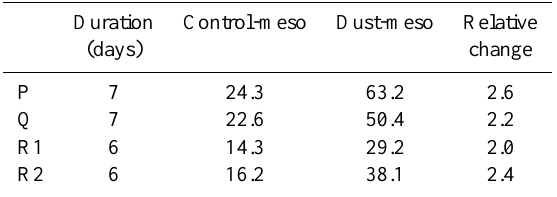
Table 4. Input of new nitrogen (µmolNm − 2 ) associated with N 2 fixation integrated over the depth of the mesocosm (12.5m) and over the duration of the experiments in the Dust-meso and